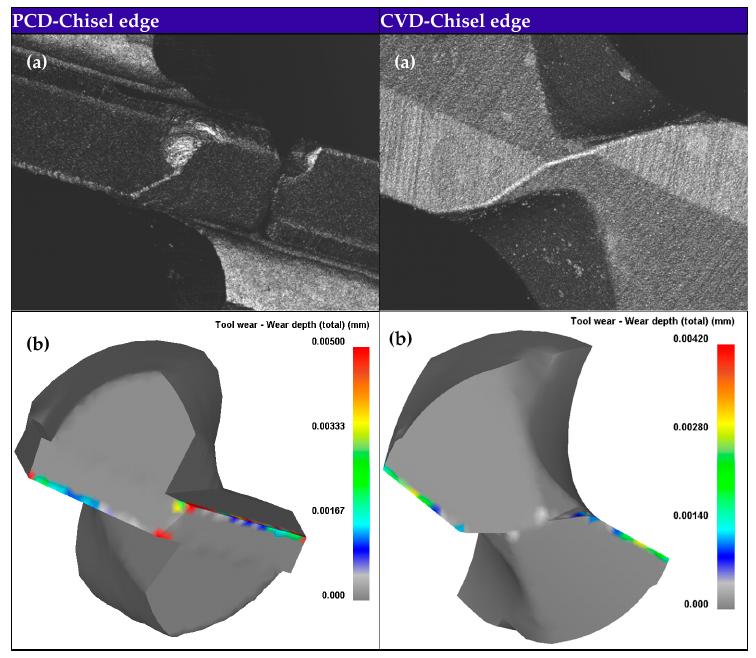
Figure 17. ( a ) Experimental and ( b ) simulated wear morphologies of PCD and CVD drills after drilling a hole. Table 5. Comparison of the MFWW between experiment and FE simulation.